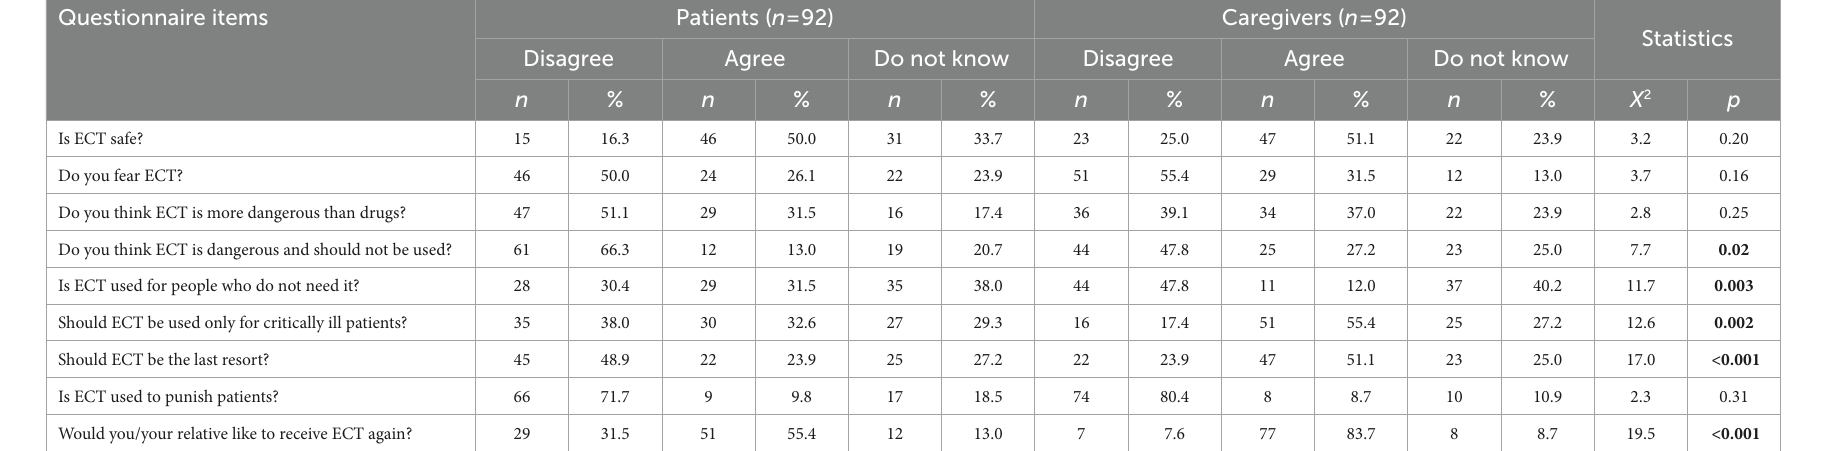
TABLE 3 Attitudes toward electroconvulsive therapy among patients and their caregivers. Questionnaire items